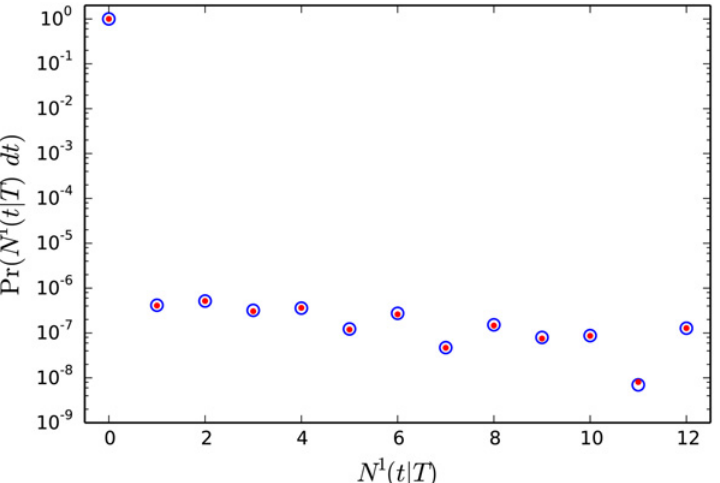
Fig 7. Probability to observe a certain number of pairs separated by the time in the interval [ t , t + dt ] on a tree of age T , N 1 ( t j T ) dt . In this plot T = 1, λ = 11, μ = 5, σ = 0.01, t = 1.5 and dt = 0.00001. Circles denote the results of numerical simulation and dots were obtained using the analytic formulas (25) for zero value and (39) for non-zero values. Note the gap between zero and non-zero probabilities due to small bin size, dt